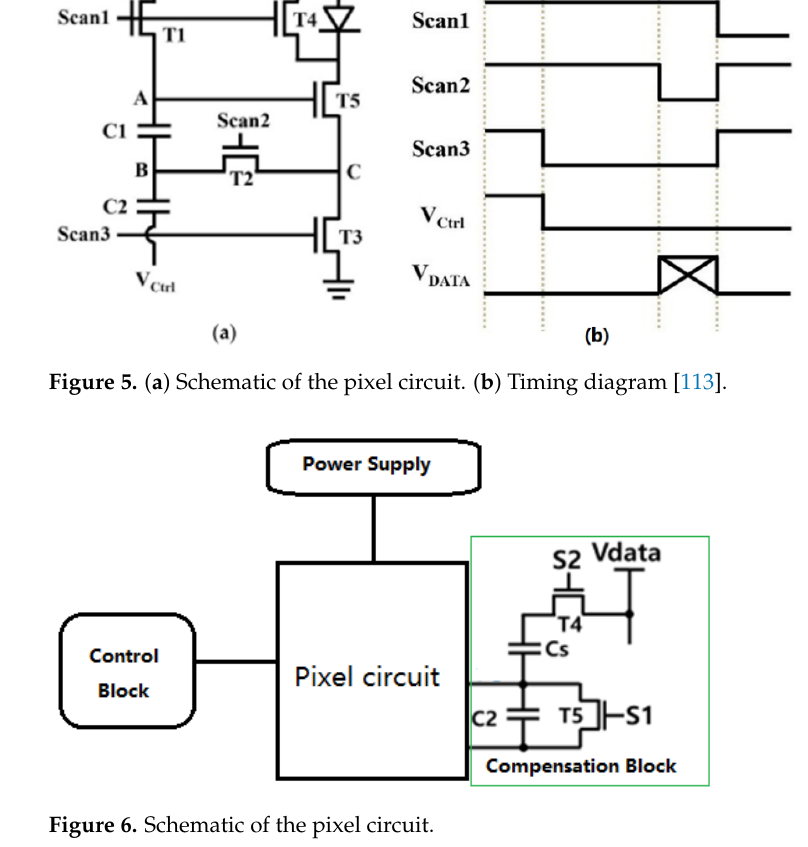
Figure 6. Schematic of the pixel circuit.